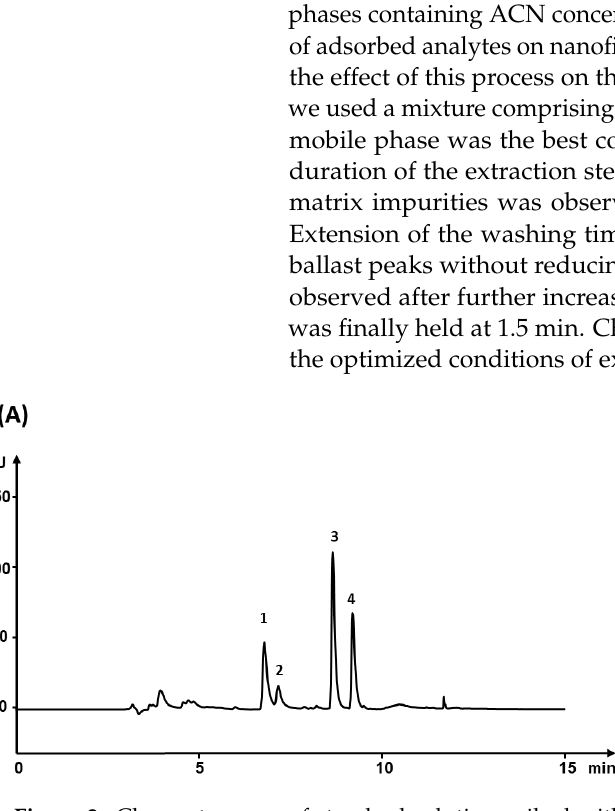
Figure 2. Chromatograms of standard solution spiked with 5000 ng mL − 1 NSAID separated on ( A ) Ascentis Express RP-Amide column and ( B ) Ascentis Express F5 column at a wavelength 270 nm. 1 — ketoprofen, 2 — naproxen, 3 — sodium diclofenac, 4 — indomethacin .